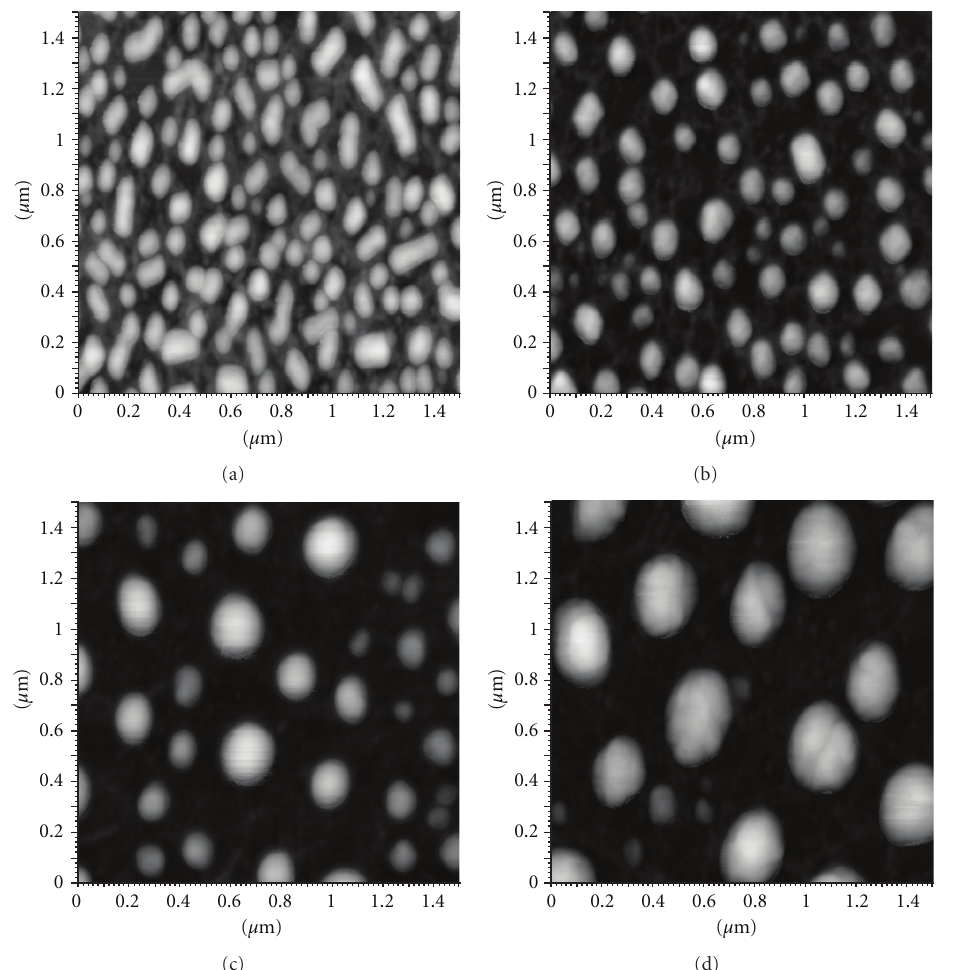
Figure 2: Kinetics of nanocrystals growth: (a) starting point, (b) 2min, (c) 3min, and (d)